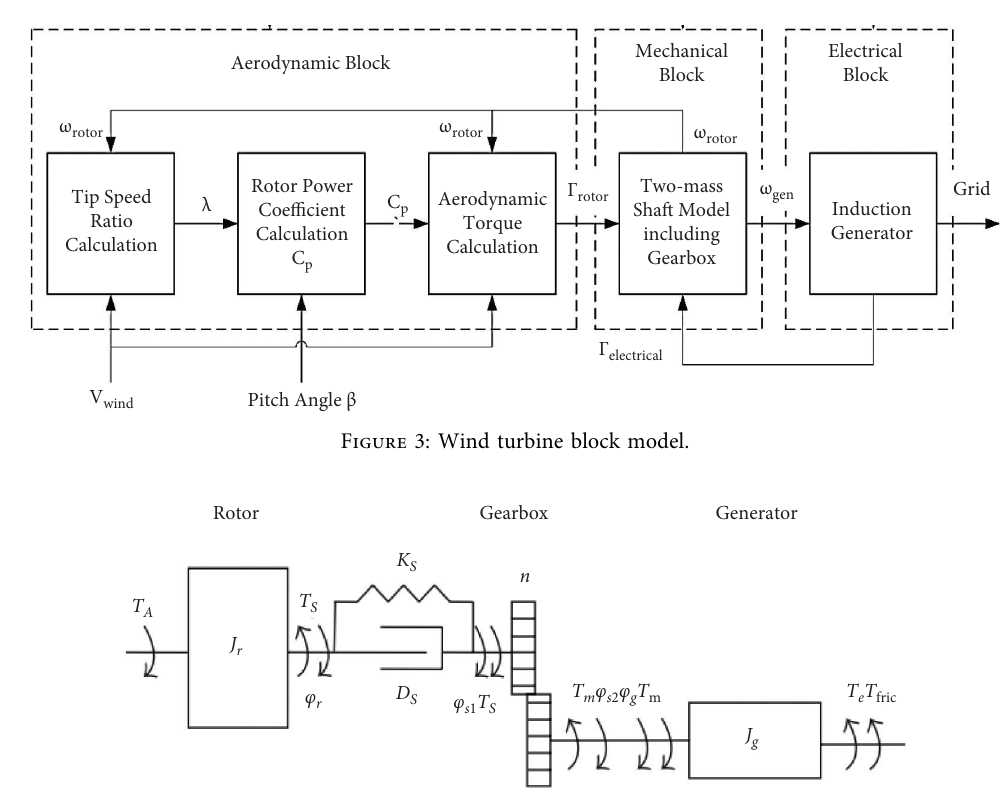
Figure 4: Drive train